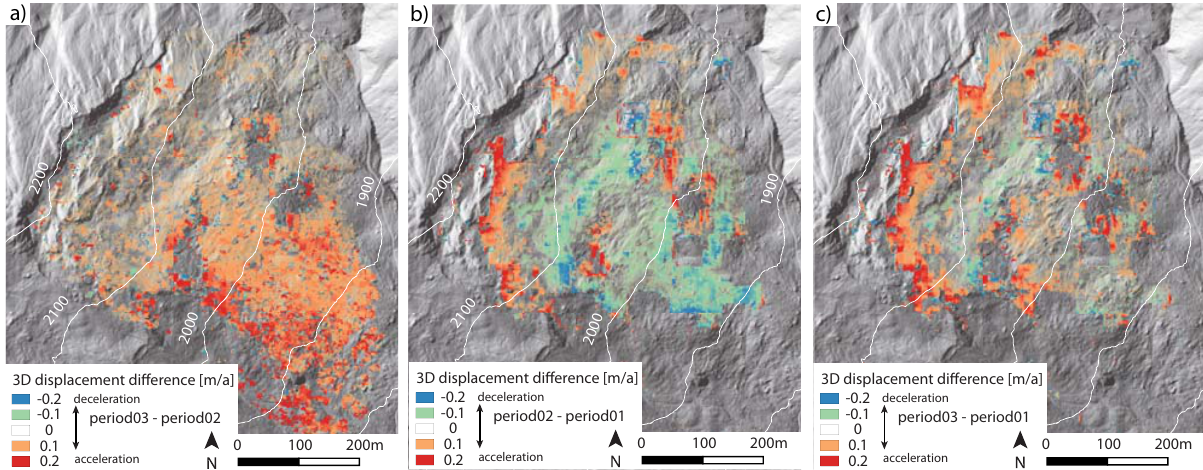
Figure 7. 3D displacement differences indicating areas of acceleration or deceleration based on annual displacements derived between